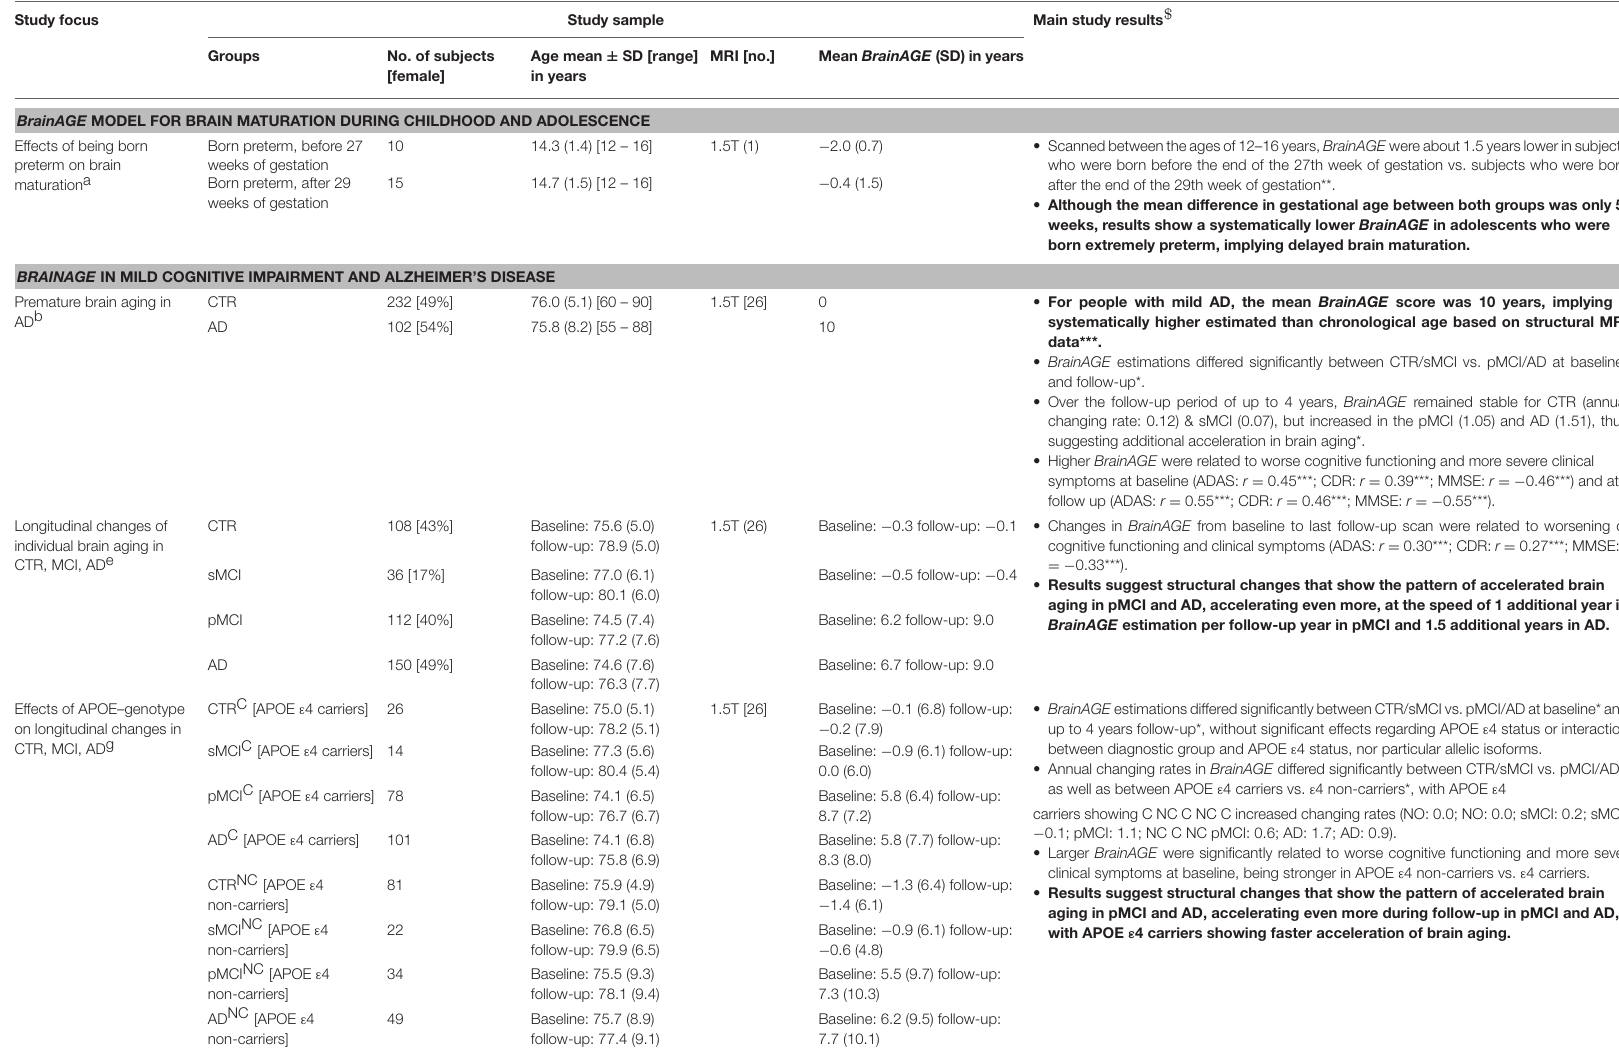
• Scannedbetweentheagesof12–16years, BrainAGE wereabout1.5yearslowerinsubjects who were born before the end of the 27th week of gestation vs. subjects who were born after the end of the 29th week of gestation**. • Although the mean difference in gestational age between both groups was only 5 weeks, results show a systematically lower BrainAGE in adolescents who were born extremely preterm, implying delayed brain maturation.